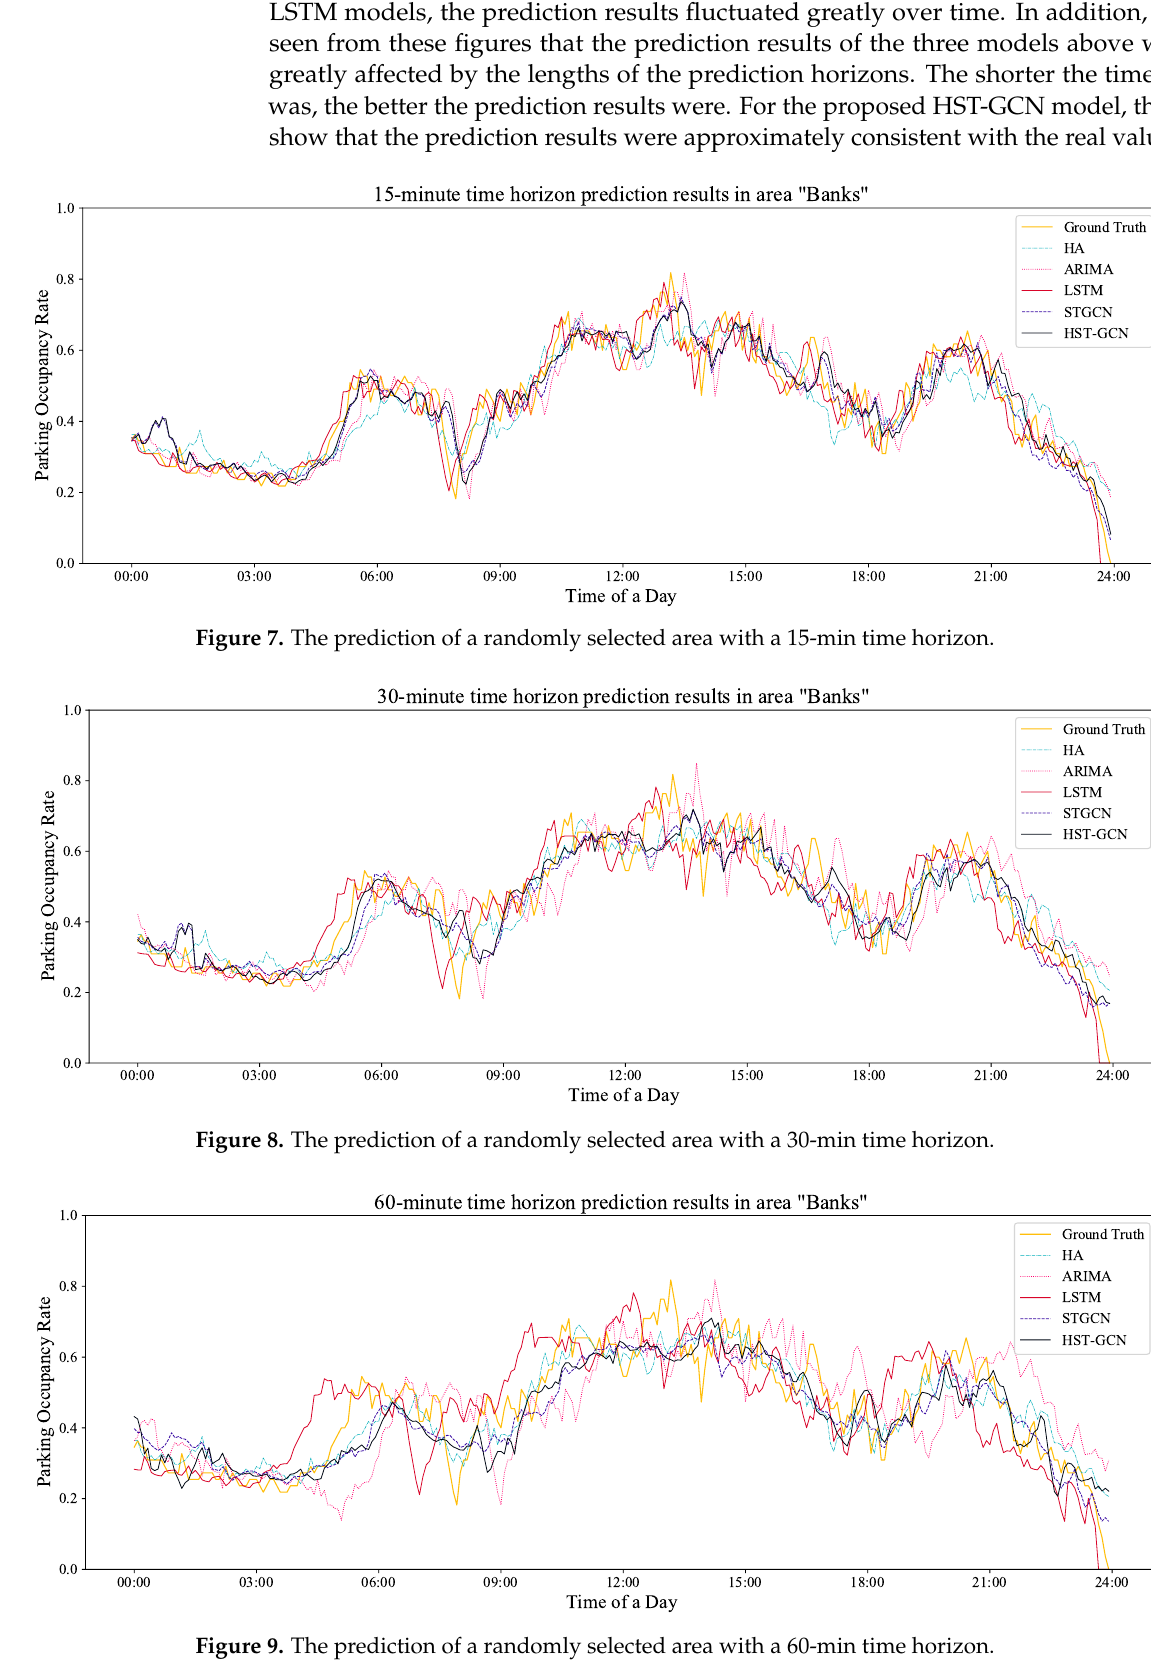
Figure 9. The prediction of a randomly selected area with a 60-min time